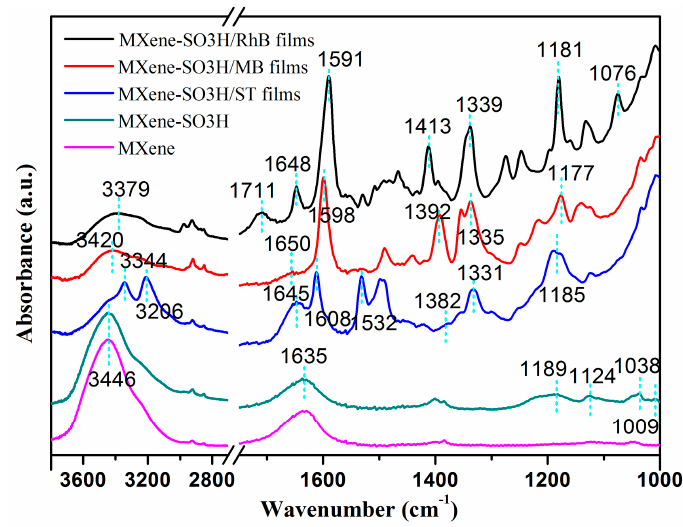
Figure 8. Fourier transform infrared (FT-IR) spectra of MXene and the obtained MXene/dye composite LB